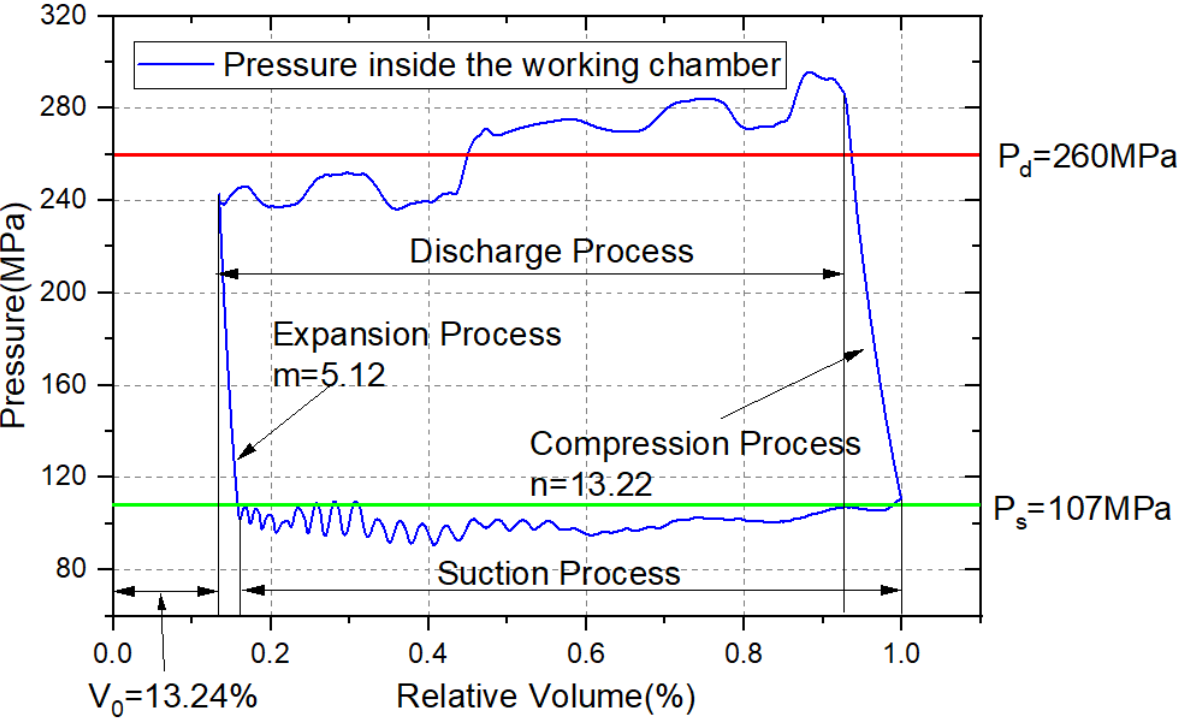
Figure 6. p-V diagrams in the working chamber.